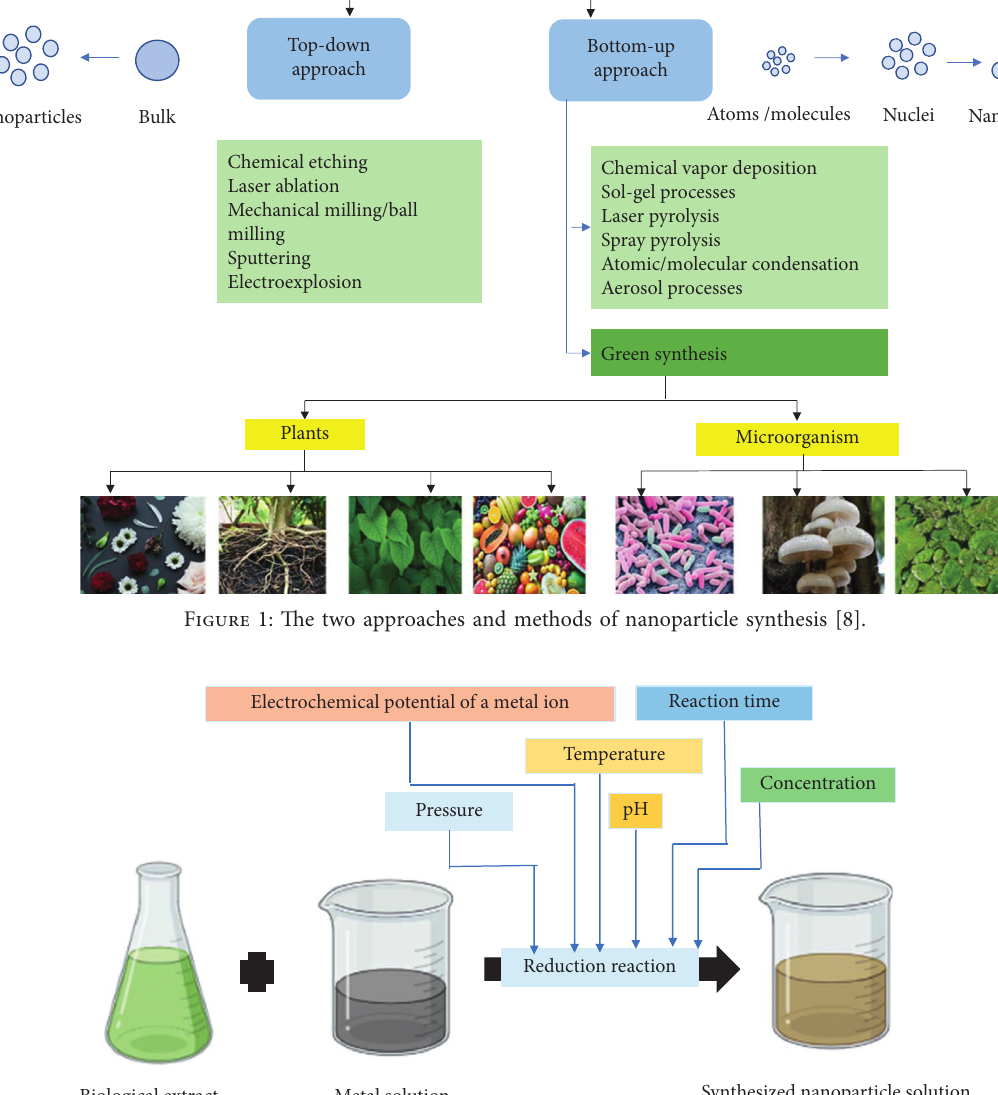
Figure 2: Basic steps of the green synthesis